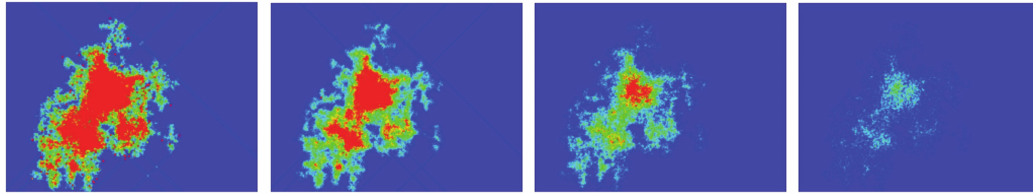
Figure 9. (Color online) Acorn simulation and spikes. (See Video 2). Cells that spiked at least once after 2000 steps. Color scale, as previously discussed, is limited between 0 (dark blue) and 20 (red). From left to right, Rules 3, 4, 5, and 6,